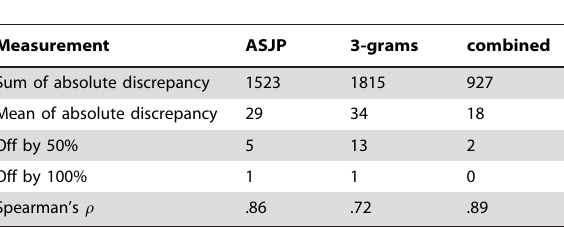
Table 3. A comparison of different dating